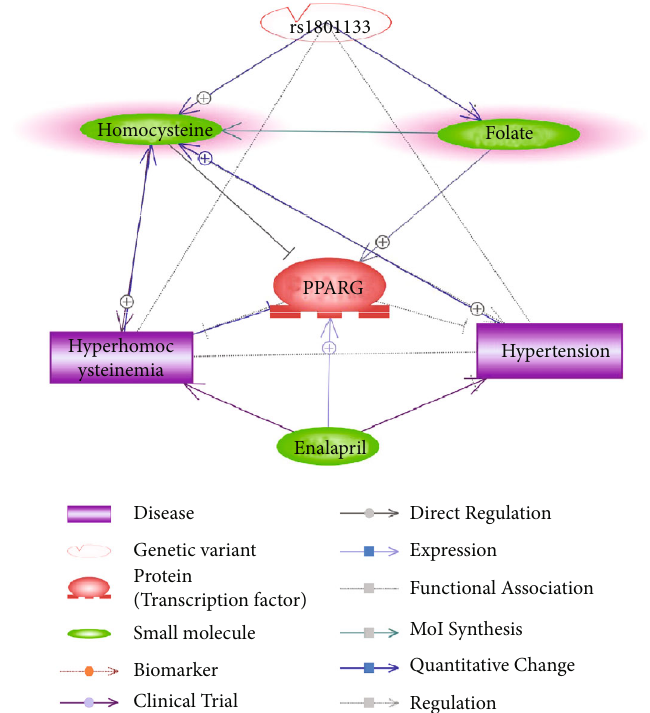
Figure 1: MTHFR-C677T-PPARG signaling pathway for H-type